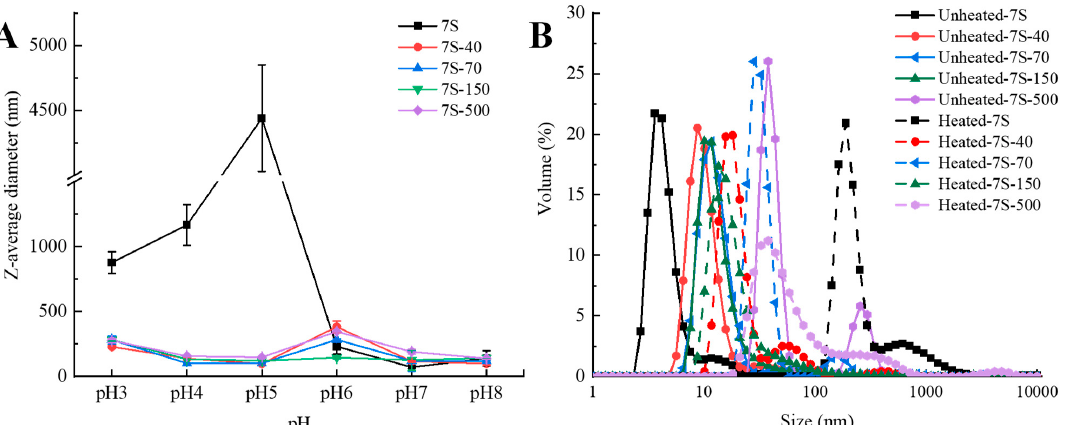
Figure 2. The influence of pH on the Z-average diameter of the 7S and 7S-DEX conjugates (7S-40, 7S-70, 7S-150, 7S-500). ( A ), and the changes in the particle size of the 7S and 7S-DEX conjugates (7S- 40, 7S-70, 7S-150, 7S-500) before and after heating at 90 °C for 30 min. ( B ), 7S: soy β -conglycinin; DEX: dextran; 40: dextran (40 kDa); 70: dextran (70 kDa); 150: dextran (150 kDa); 500: dextran (500 kDa).